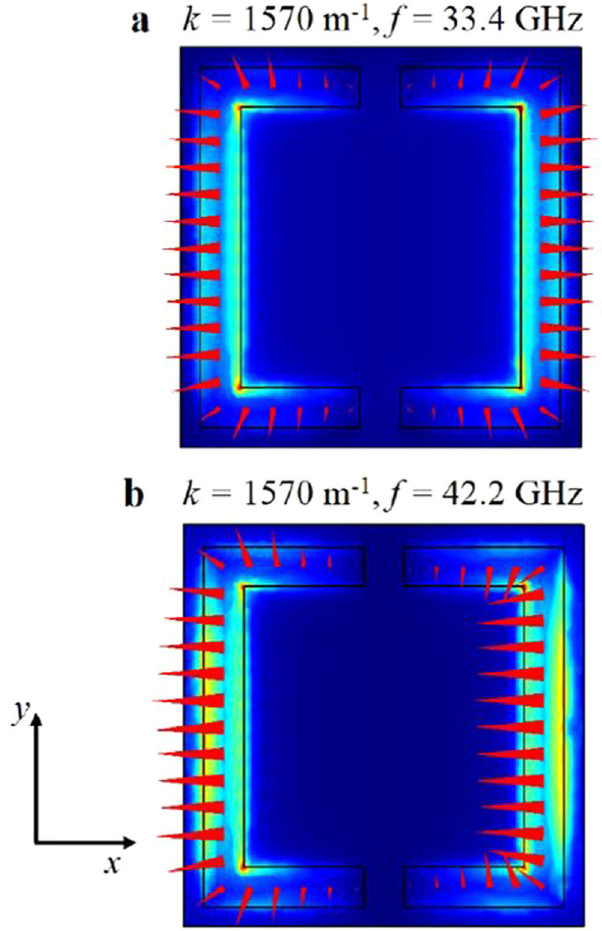
Figure 6. Simulated eigenmodes of the double split CSRR showing the electric field magnitude (background colour - red indicates high field and blue indicates low field) and direction (red vector arrows) plotted at the Brillouin Zone edge for ( a ) the lower and ( b ) the higher frequency modes. Note that although the model still shows a solution for the lower mode (shifted up in frequency), there is no longer an overall component of the electric field. The higher mode is largely unaffected by the addition of the extra